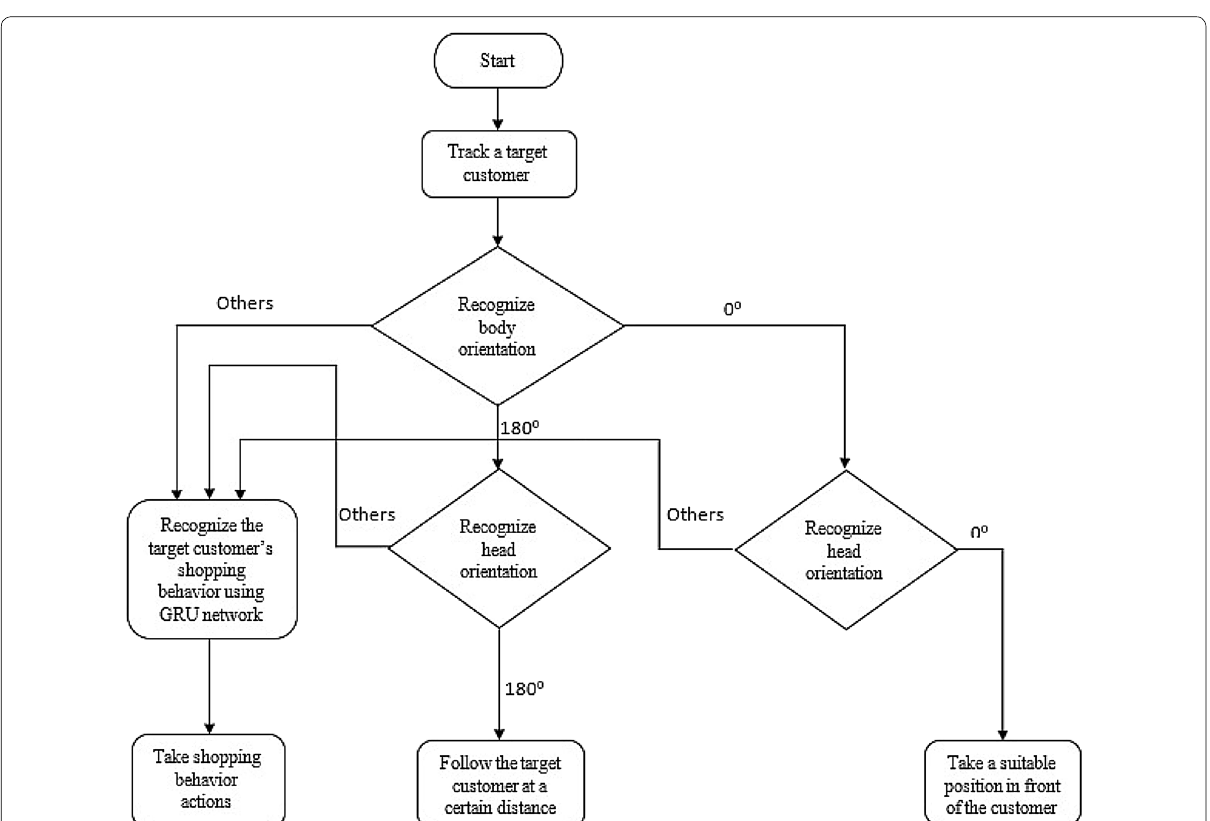
Fig. 9 Flowchart of our proposed shopping support